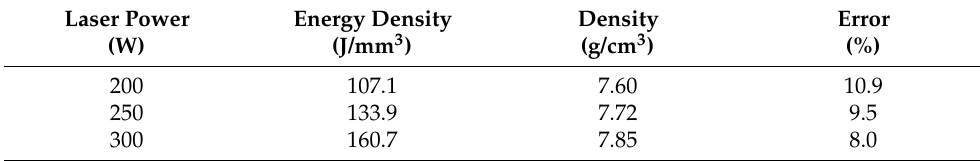
Table 2. Density of Fe 30 Co 70 alloy. The calculated theoretical density is 8.58 g/cm 3